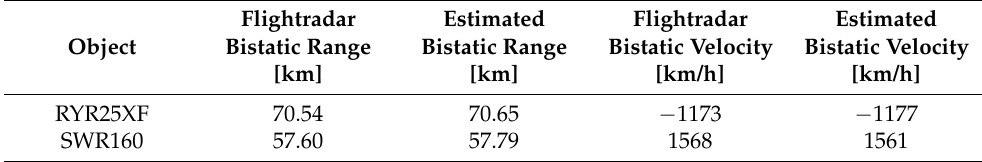
Table 1. Bistatic target parameters for the transmitter in Srem—April 2019.